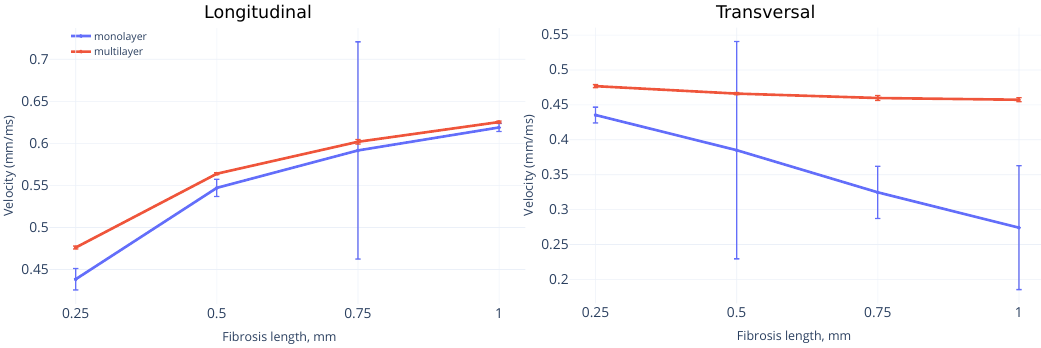
Figure 8. Dependence of the conduction velocity on the obstacle length in mono- (n = 1, blue lines) and multilayer (n = 10, red lines) models at 35% fibrosis for longitudinal ( Left ) and transversal ( Right ) wavefront direction.